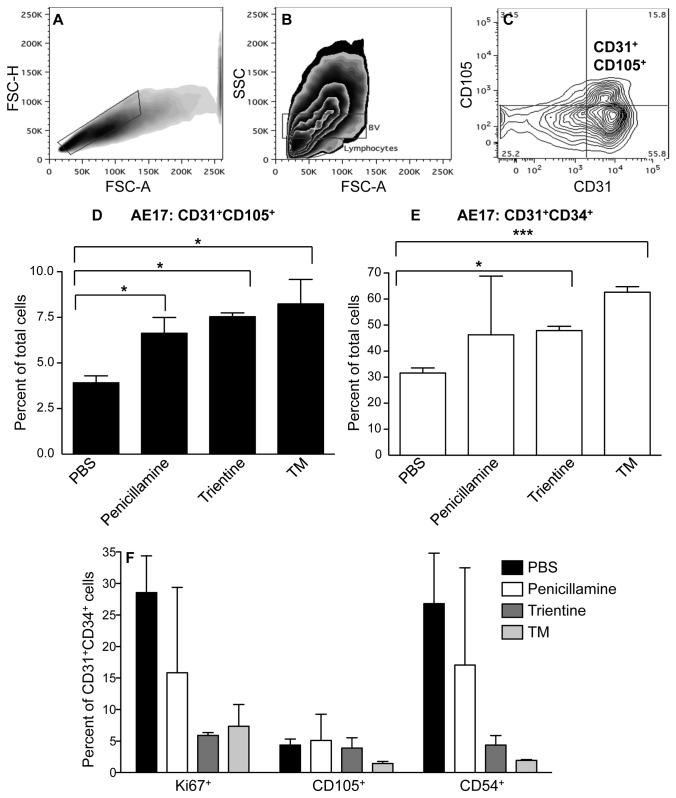
Copper lowering in vivo reduces tumor endothelia proliferation and ICAM (CD54) expression.Mice treated with PBS, TM, penicillamine or trientine were sacrificed when tumors reached 100 mm2 and tumor endothelia analyzed by flow cytometry. Single cells were identified by excluding doublets by gating on FSC-A versus FSC-H plots; A. Isotype controls and single stains were used to set up negative and positive regions (not shown). Lymphocytes were excluded by gating. Backgating on CD31+CD105+ revealed the FSC/SSC region associated with tumor blood vessels (BV:B). CD31+CD105+ angiogenic (C and D) or CD31+CD34+ normal (E) endothelial cells were identified, gated and quantified. The proportions of Ki67+, CD105+ and CD54+ cells within each gate were determined (F). Pooled data counting > 20,000 CD31+CD105+ or CD31+CD34+ cells per mouse from 2 mice/treatment group and 4 control mice is shown as mean ± SEM. * p < 0.05; *** p < 0.001.